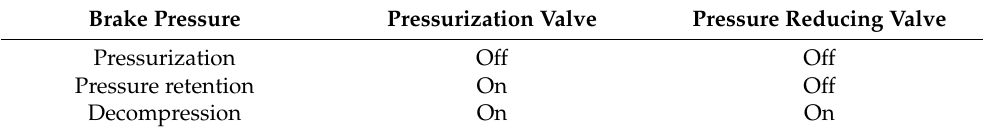
Table 3. ABS operating characteristics.